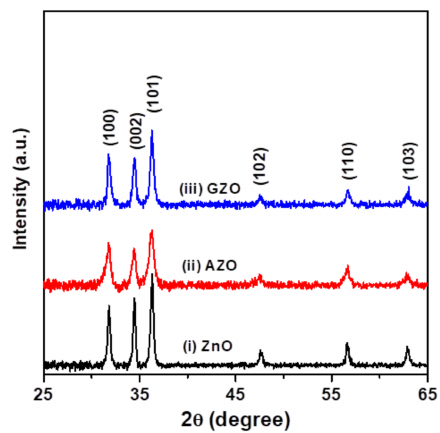
Figure 2. X-ray diffraction (XRD) patterns of ( i ) ZnO, ( ii ) AZO, and ( iii ) GZO thin films deposited on glass substrates by a sol-gel spin-coating